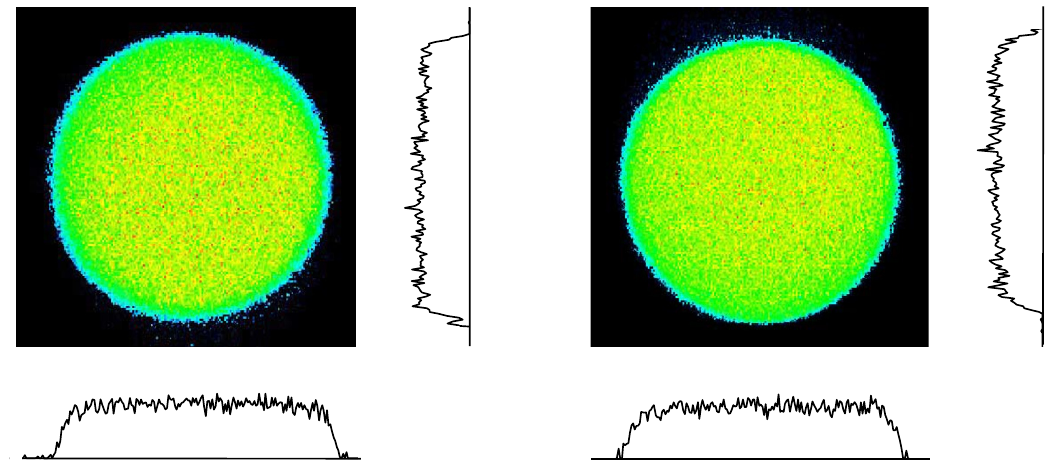
Figure 7. Near-field spatial intensity distributions of the green beams from each crystal side.